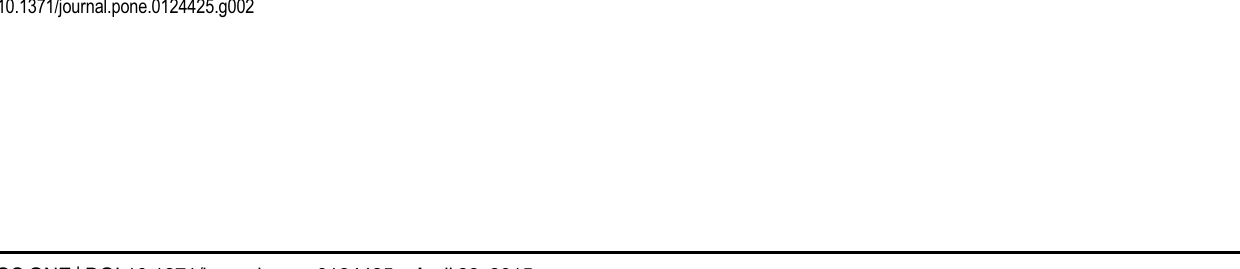
PLOS ONE | DOI:10.1371/journal.pone.0124425 April 28,